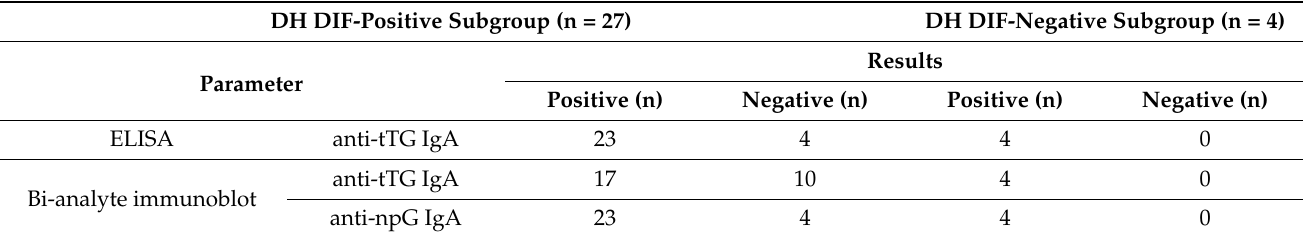
Table 2. The positive and negative results of ELISA and b-aIB in the subgroups of DH patients. DH DIF-Positive Subgroup (n = 27) DH DIF-Negative Subgroup (n = 4)